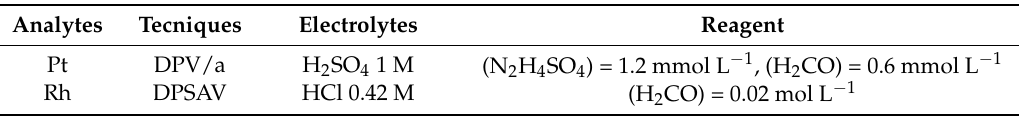
Table 1. Operating parameters for the voltammetric analysis (differential pulse voltammetry and adsorptive stripping voltammetry) of the solutions obtained from the ashes of potato samples.